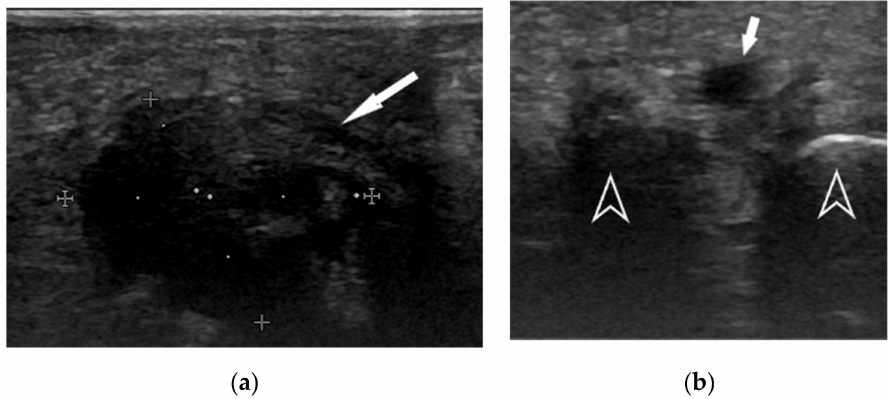
Figure 1. Dynamic ultrasound ( a ) showing a neuroma of the III intermetatarsal space (arrow). During Mulder’s test ( b ), the lesion (arrow) is pushed superficially, thus becoming apparent between the adjacent metatarsal heads (arrow